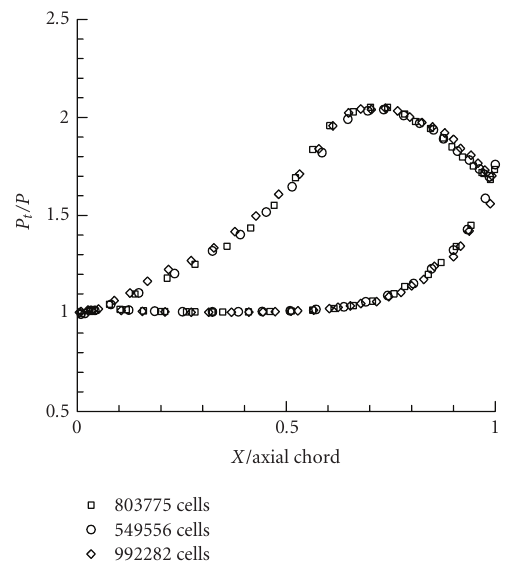
Figure 3: Distribution of pressure ratio ( P t /P ) at 90% of the blade span for 549556, 803775, and 992282